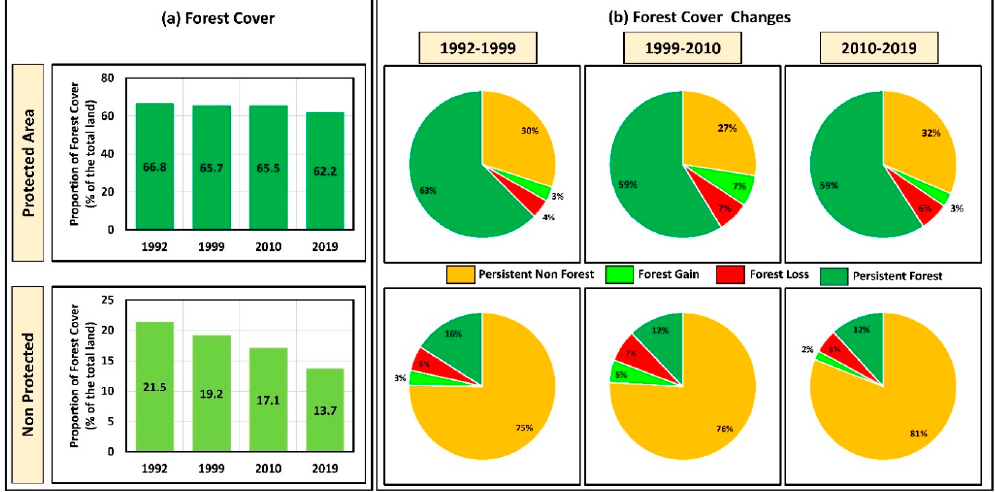
Figure 4. (a) Forest cover; (b) Forest cover changes in the DZ of Sri Lanka both inside and outside the Figure 4. ( a ) Forest cover; ( b ) Forest cover changes in the DZ of Sri Lanka both inside and outside the protected areas for the three decadal timeframes. protected areas for the three decadal